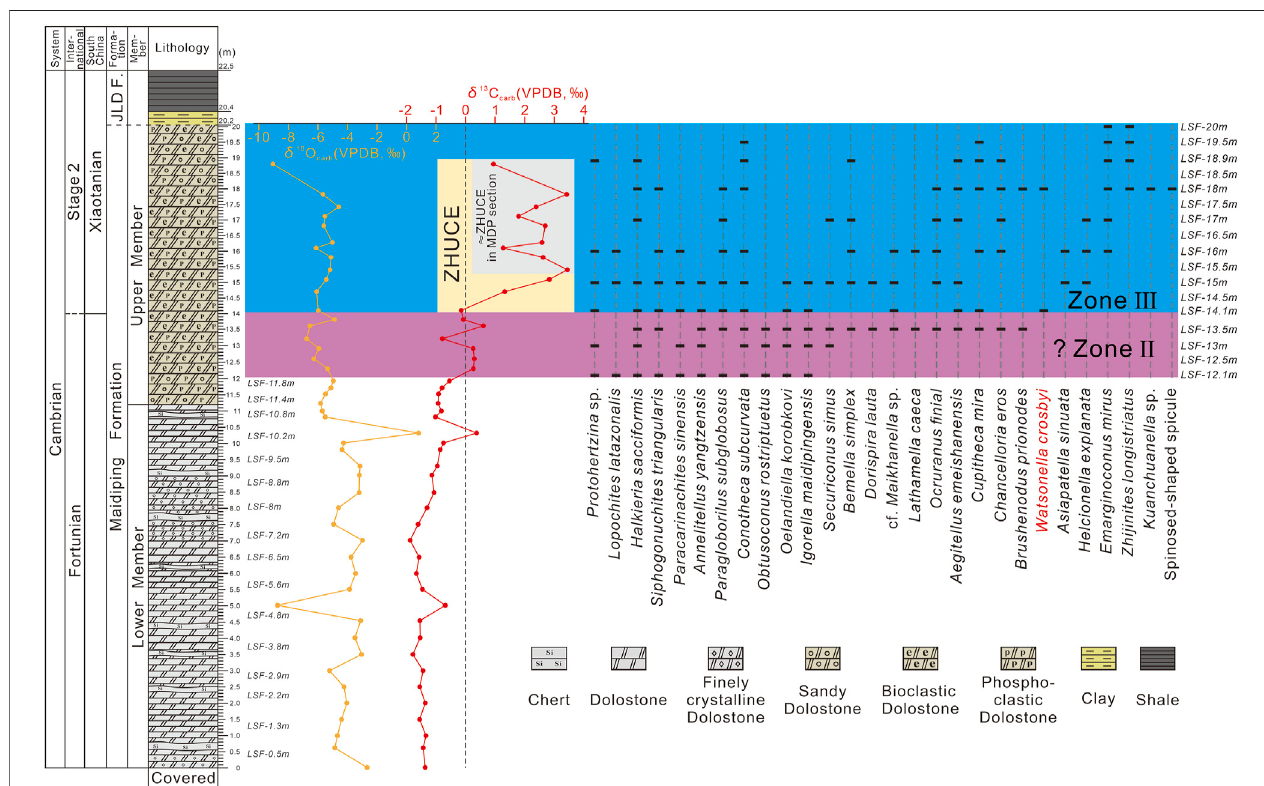
FIGURE 2 | Stratigraphic column of the Fandian section with the distribution of small shelly fossils and the pro fi le of δ 13 C and δ 18 O values of carbonate in the Maidiping Formation. Abbreviation: JLD F., Jiulaodong Formation; MDP, Maidiping; LSF, samples collected for the study of small shelly fossil at the Fandian section in Leshan City (Chronostratigraphy based on Steiner et al., 2007, 2020; Zhu et al., 2019).